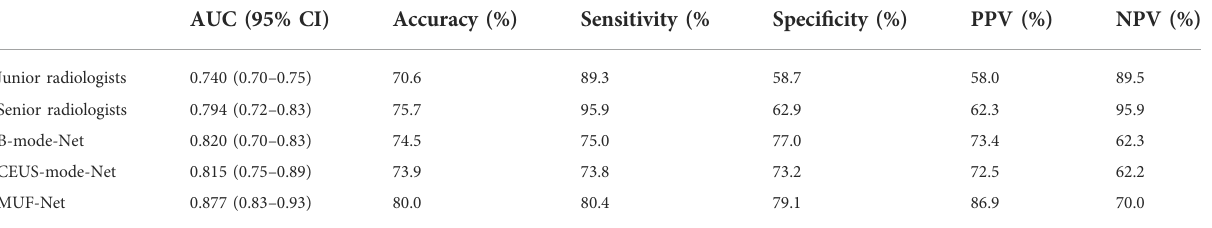
TABLE 3 Classi fi cation performance of deep learning models and radiologists.